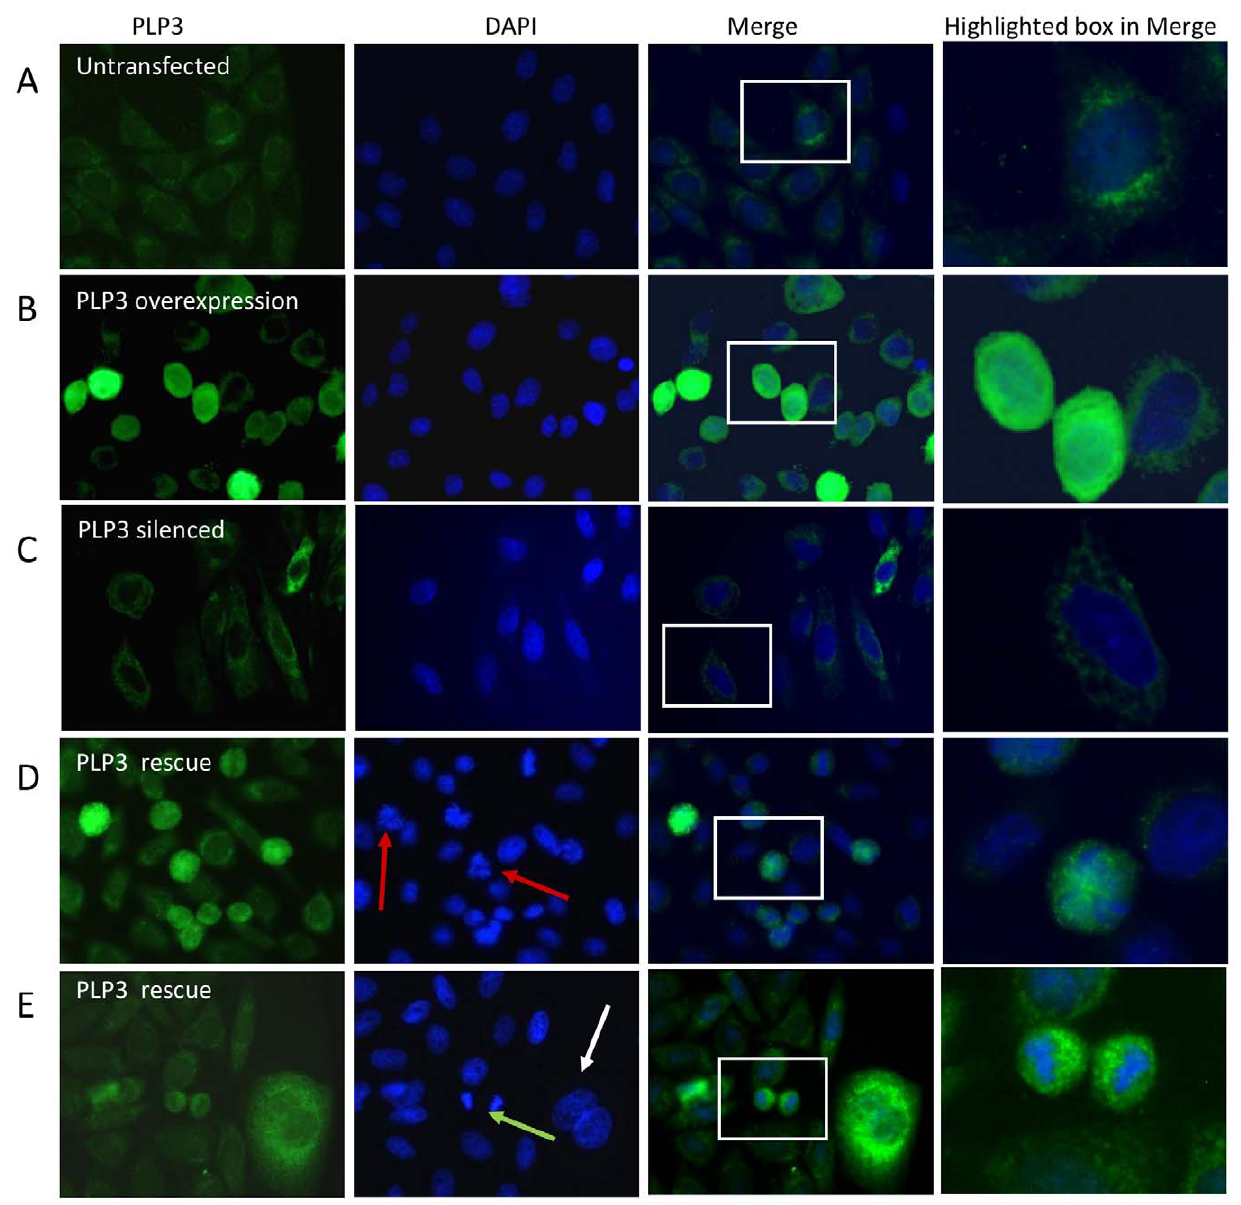
Figure 3. Rescue of PhLP3 silenced CHO LB01 cells promotes aberrant cell division. LB01 cells were silenced and rescued as described in the methods section and then fixed and co-stained for PhLP3 (green) and with the nuclear DAPI stain (blue). PhLP3 overexpression in LB01 cells leads to more ‘rounded’ cells compared to untransfected controls (A v B) whilst siRNA silencing promotes morphological changes including elongated cells and nuclei and adherent growth (A v C). When LB01 cells were co-transfected with mouse PhLP3 siRNA and human PhLP3 DNA (D and E) the elongated phenotype observed in the PhLP3 silenced cells was no longer present and thus the cells were considered ‘rescued’. Co-transfected cells were either in early anaphase (red arrows), late anaphase (green arrow) or exhibited enlarged nuclei (white